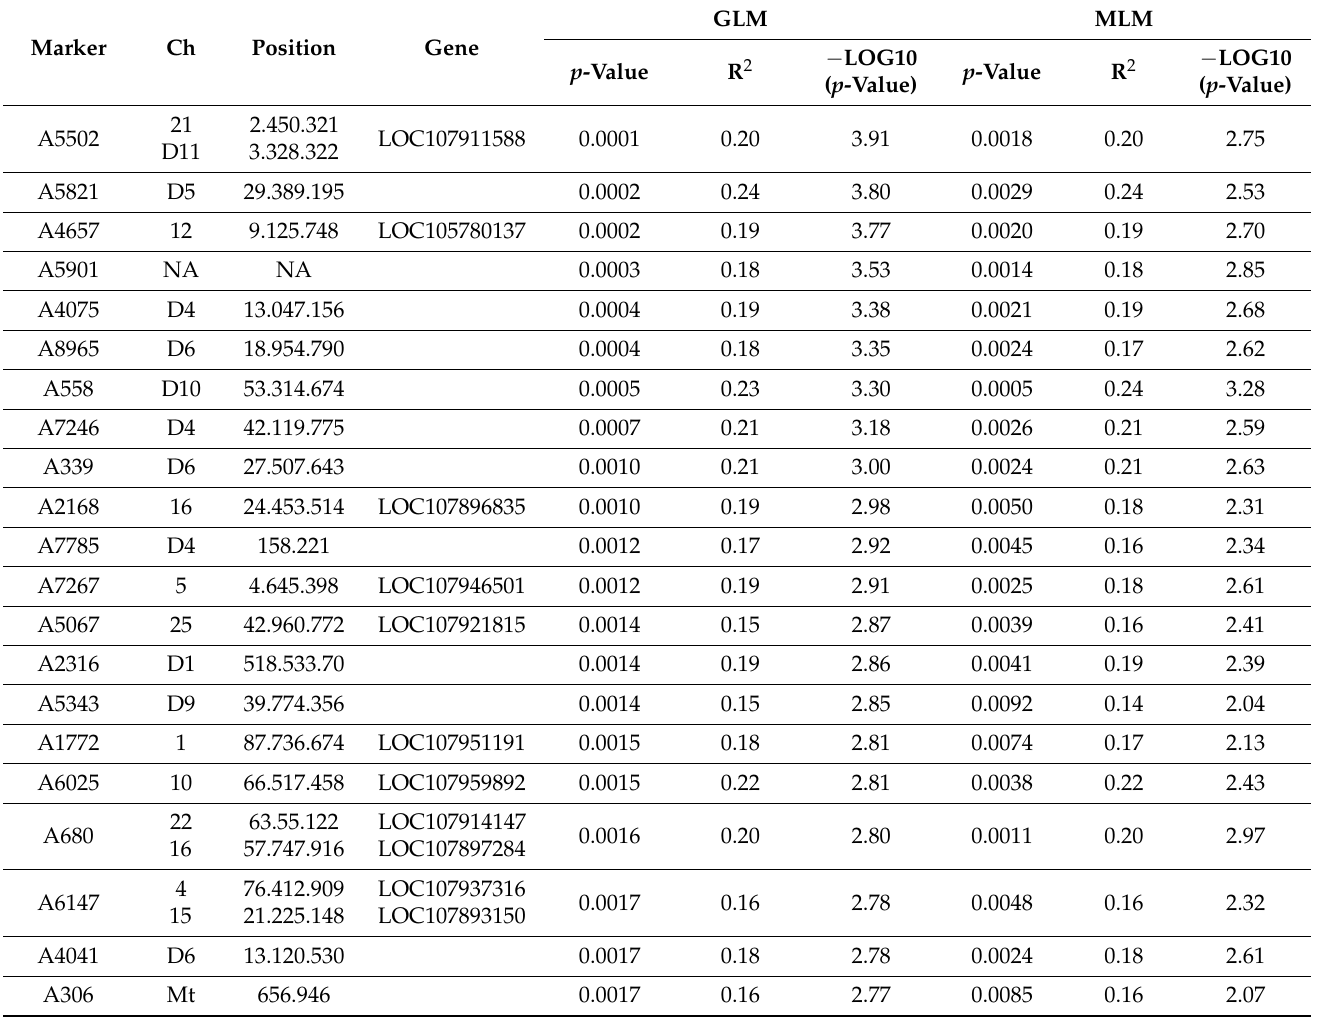
Table 3. Markers associated with non-defoliating pathotype (Vd11 isolate) of Verticillium wilt disease.